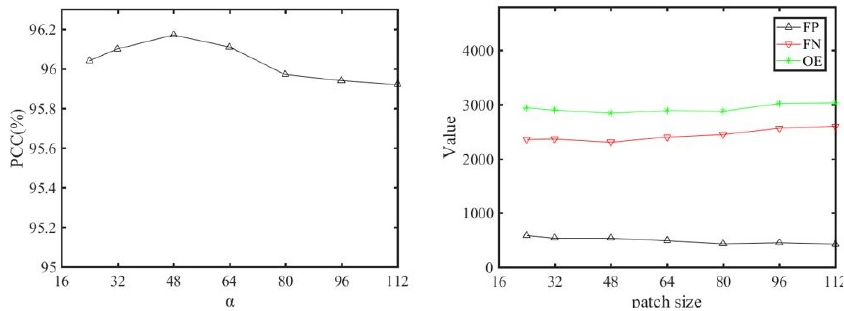
Figure 23. The influence of the patch size evaluated on the Farmland D